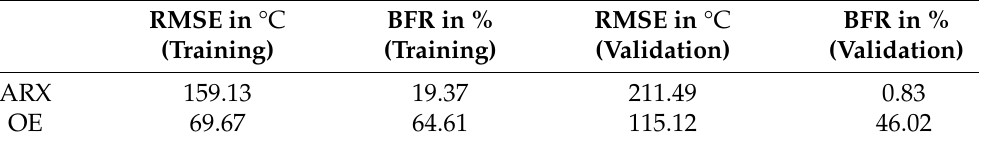
Figure 13. Time series for single track case at spatial instance ( s 1 , s 2 ) = ( 5,2 ) for both, training and validation data. Left axis (blue): Observed temperature y (solid line), predicted temperature ˆ y (dashed line), and absolute value of residuals (cid:101) (dotted line). Right axis (red): Corresponding laser power. ( a ) ARX model, training data; ( b ) ARX model, validation data; ( c ) OE model, training data; ( d ) OE model, validation data. Table 4. Performance of ARX and OE models for simulation assessed for training and validation data, respectively, for multiple tracks case.